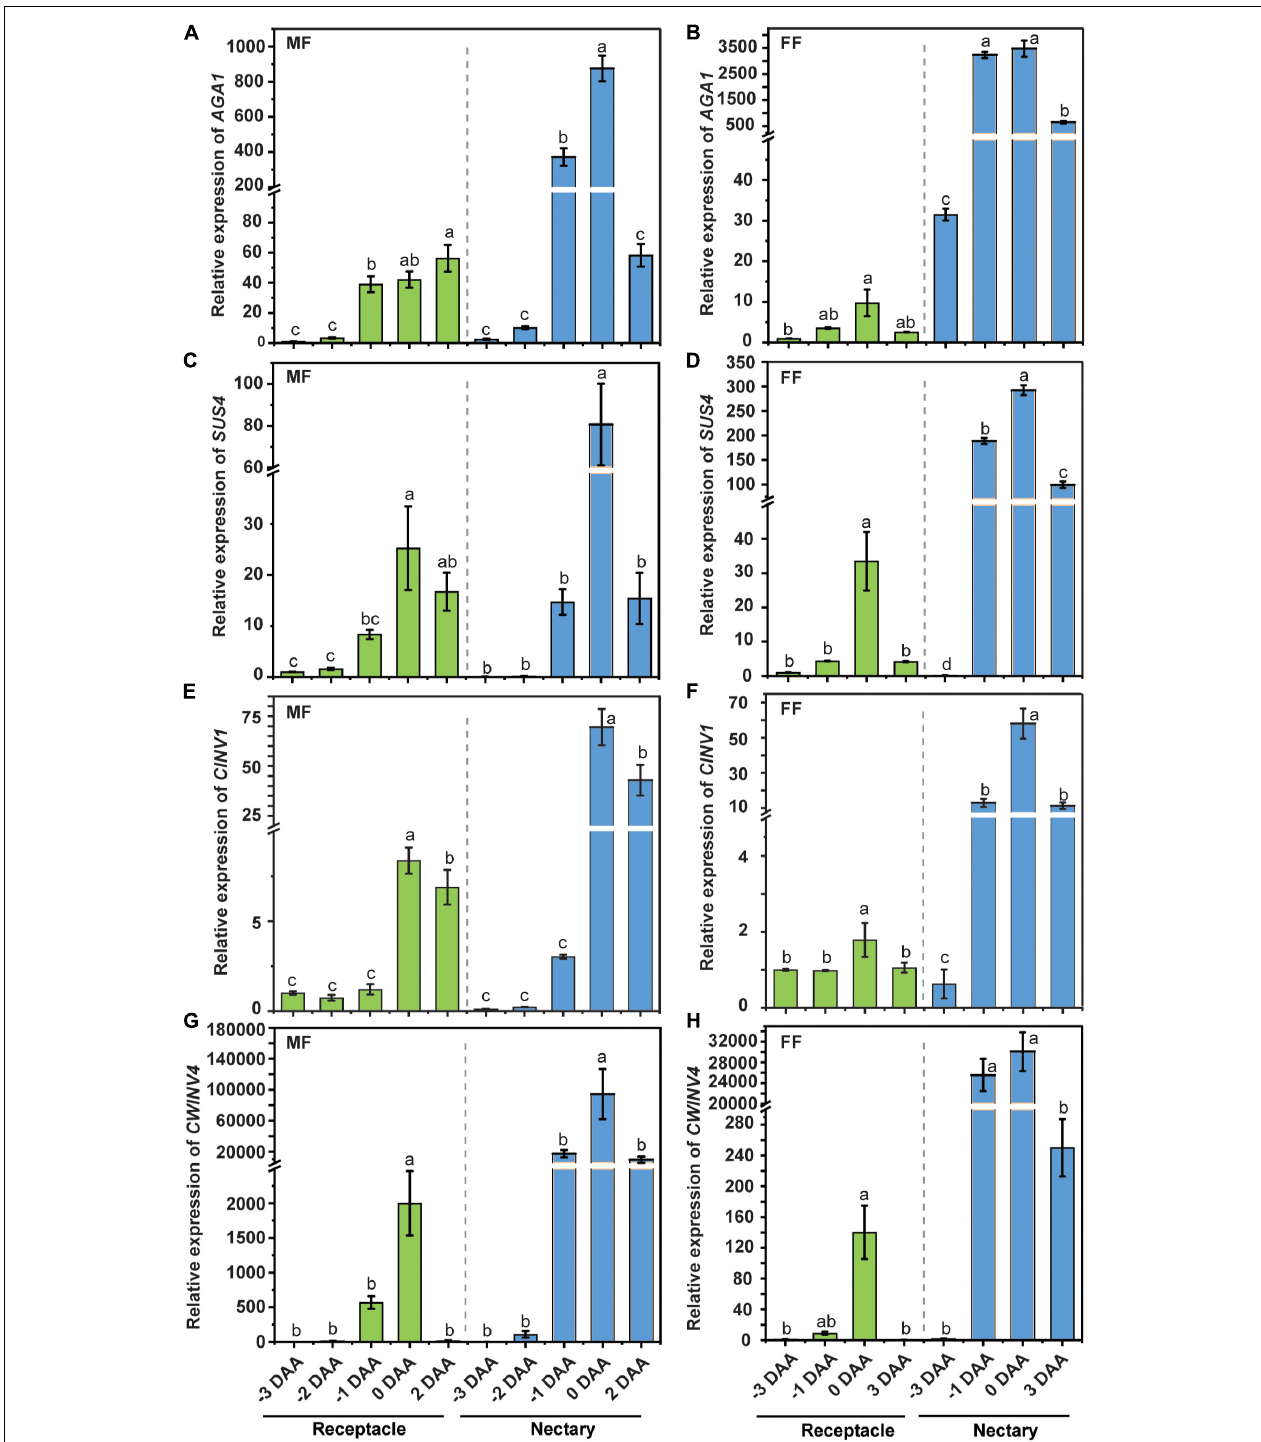
FIGURE 6 | The expression pattern of sugar metabolism enzymes in cucumber receptacle and nectary. The relative expression level of cucumber AGA1 , SUS4 , CINV1 , and CWINV4 in male (A,C,E,G) and female flowers (B,D,F,H) . DAA, days after anthesis; − 3, − 2, − 1 DAA, being 3, 2, and 1 day(s) before anthesis, respectively; 0 DAA, the day of anthesis; and 2 and 3 DAA, being 2 and 3 days after anthesis, respectively. Mean values ± SE of three independent biological replicates were shown. Statistical analyses were performed using one-way ANOVA followed by multiple comparisons using the Fisher’s LSD method ( P -value < 0.05) in each tissue. Gene IDs: AGA1 (Csa4G631570), alkaline a-galactosidase 1 ; SUS4 (Csa5G322500), sucrose synthase 4 ; CINV1 (Csa5G615240), cytosol invertase 1 ; CWINV4 (Csa2G351670), cell wall invertase 4 .